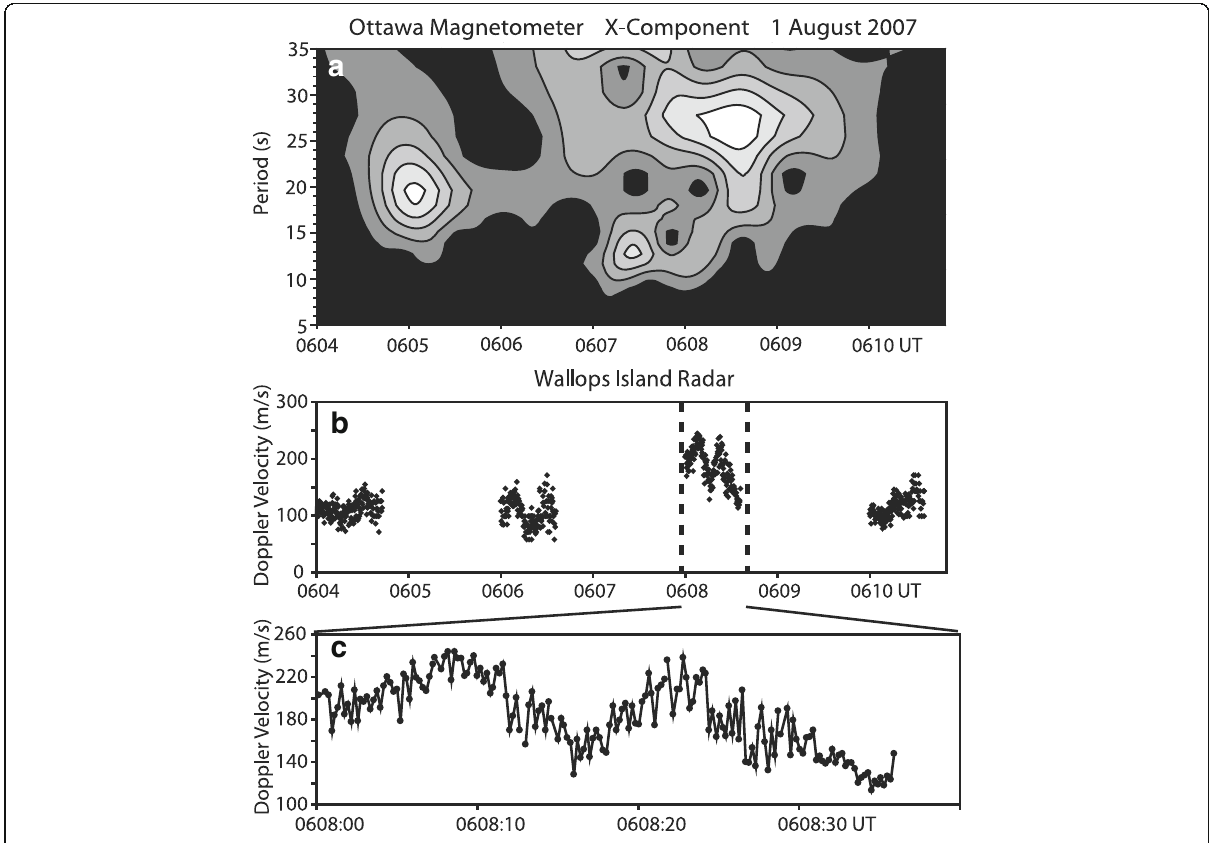
Fig. 35 A comparison of magnetometer data from Ottawa with WAL LOS velocity. a The dynamic spectrum of the X component data from the Ottawa magnetometer for the interval 0604 to 0611 UT on 1 August 2007. The contours represent different levels of power with the lighter colors the higher power. b The high time resolution estimates of the LOS velocity from WAL for the same period. c The shorter interval is marked by vertical dashed lines. Reproduced from Fig. 3 of Greenwald et al.